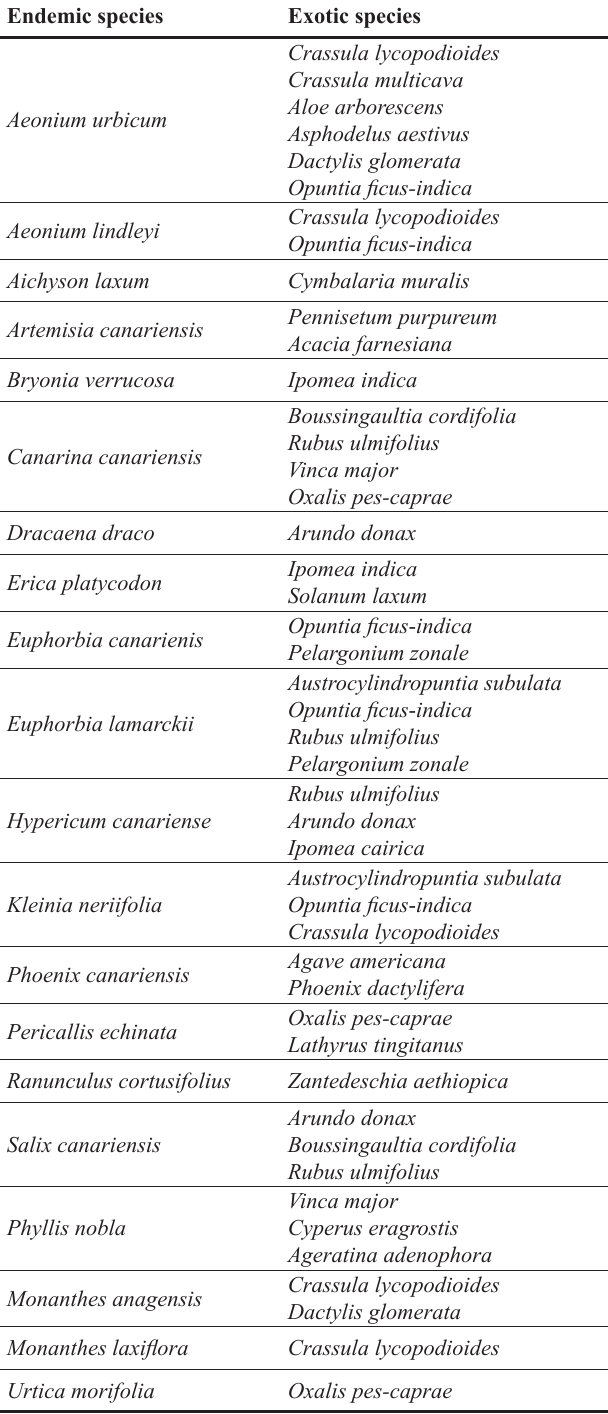
Table 2 – Interspecies coexistence of exotic plants with endemic plants in Anaga Rural Park (Tenerife, Canary